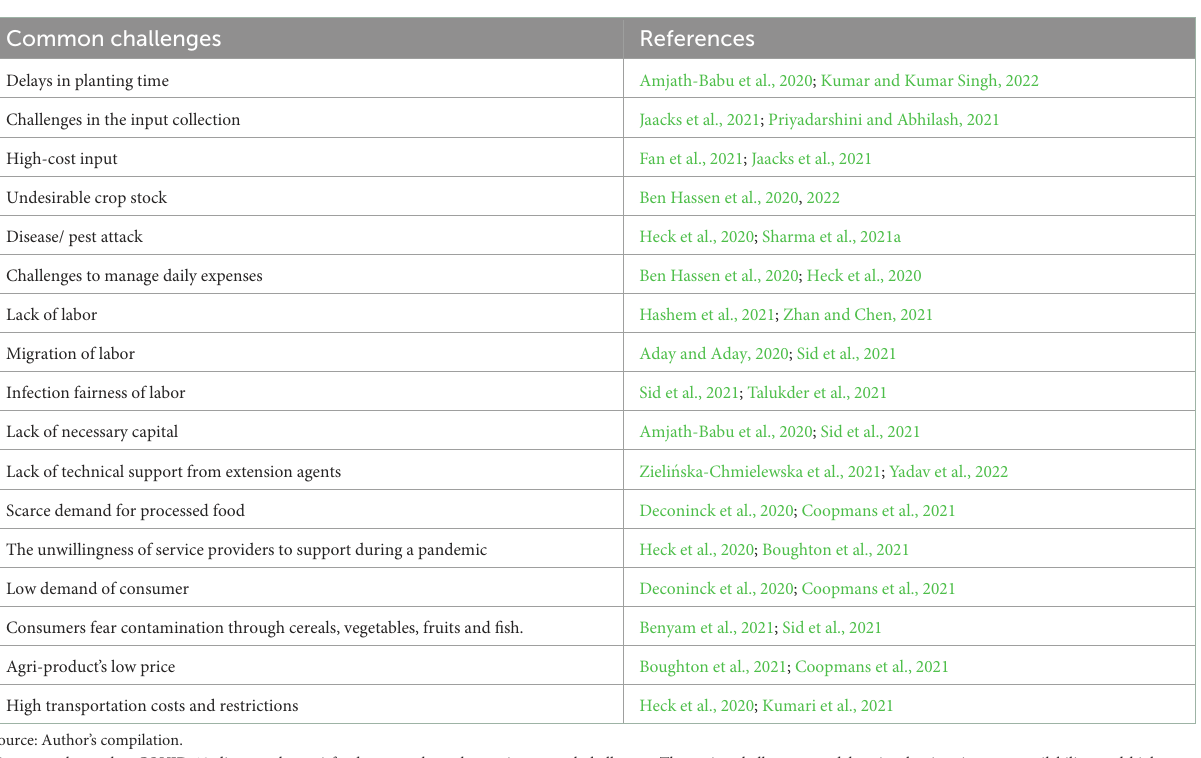
TABLE 4 Common challenges confronted by small farmers.